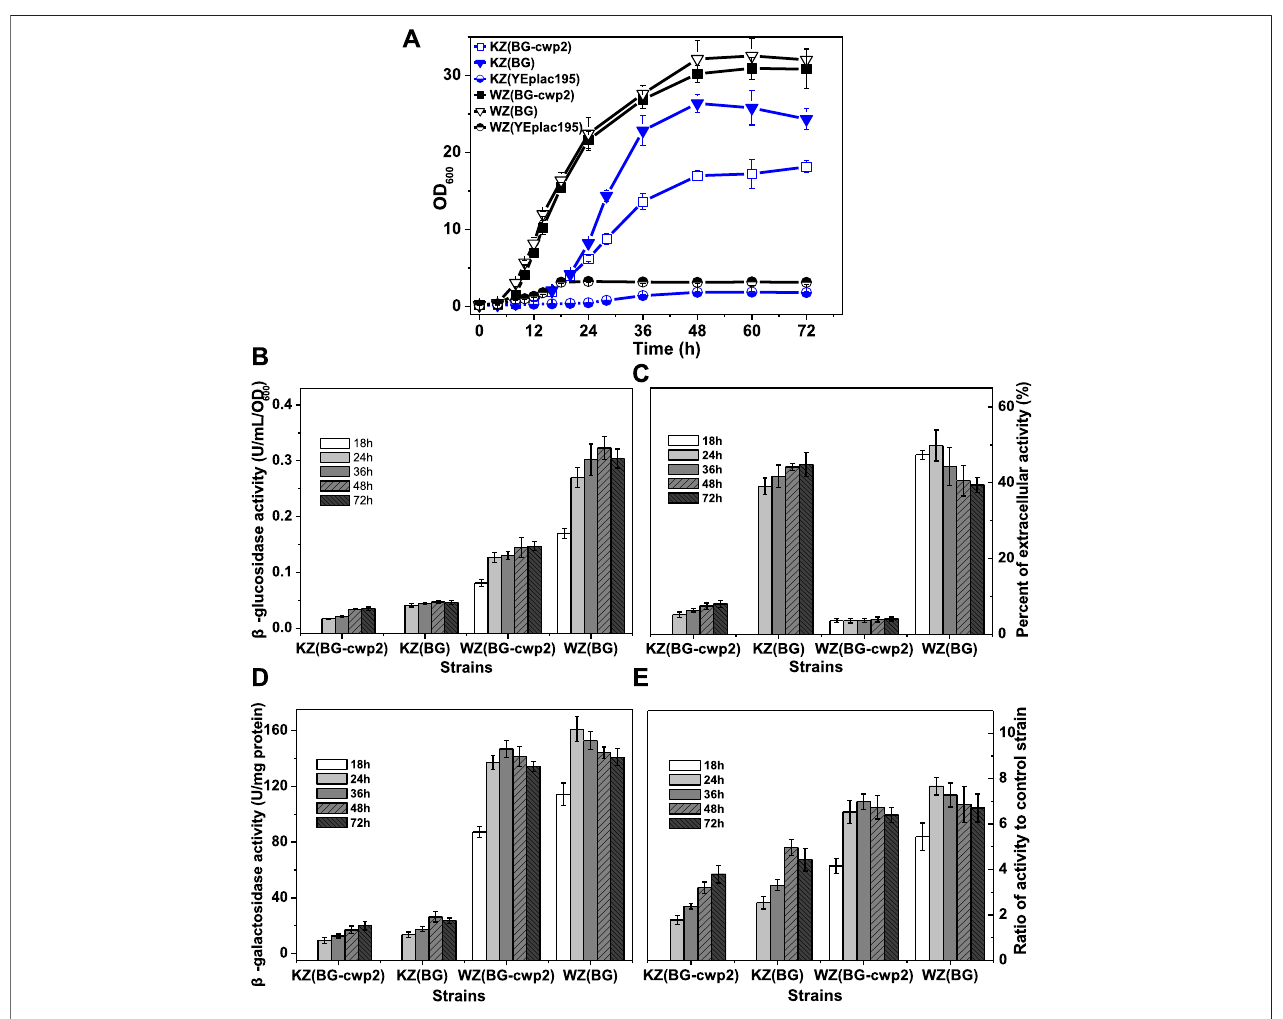
FIGURE 3 | The growth, β -glucosidase, and β -galactosidase activities of the recombinant strains aerobically in 2% cellobiose. (A) The growth curve; (B) total β - glucosidaseactivity(U/ml/OD 600 ),notdetectedforcontrolstrainsKZ(YEplac195)andWZ(YEplac195); (C) thepercentofextracellular β -glucosidaseactivity(%); (D) the β -galactosidase activity (U/mg protein); and (E) the ratio of β -galactosidase activity value of four strains to that of control strain KZ (YEplac195) and WZ (YEplac195), 5.30 ± 0.83 and 21.0 ± 0.95 U/mg protein, respectively. The original data was shown in Supplementary Material Table 2